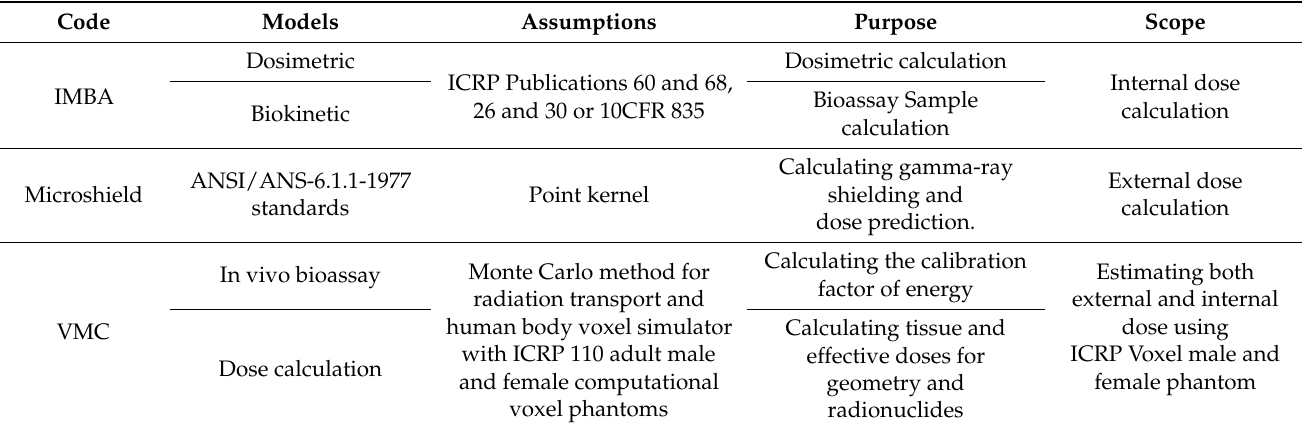
Table 3. Computer code comparison, models and